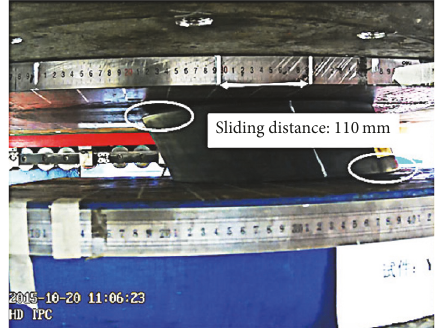
Figure 6: Specimen Y2-8/30-UB subjected to 250% ESS.